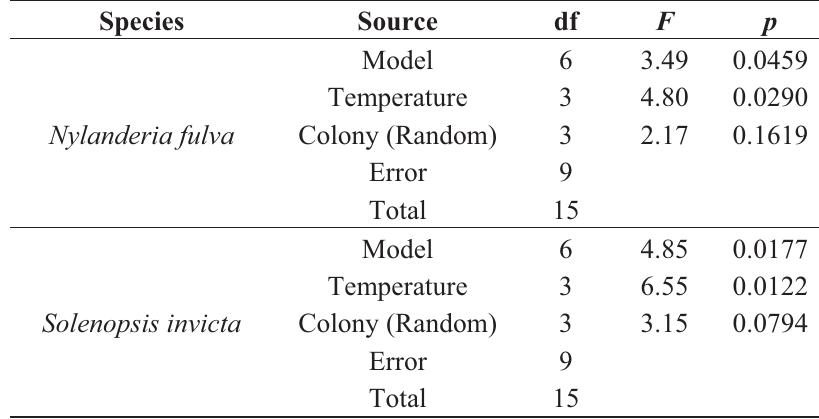
Table 2. A two-way ANOVA summary table by species evaluating the tunneling performance of Nylanderia fulva and Solenopsis invicta at 15.0, 18.0, 20.0, and 22.0 °C.